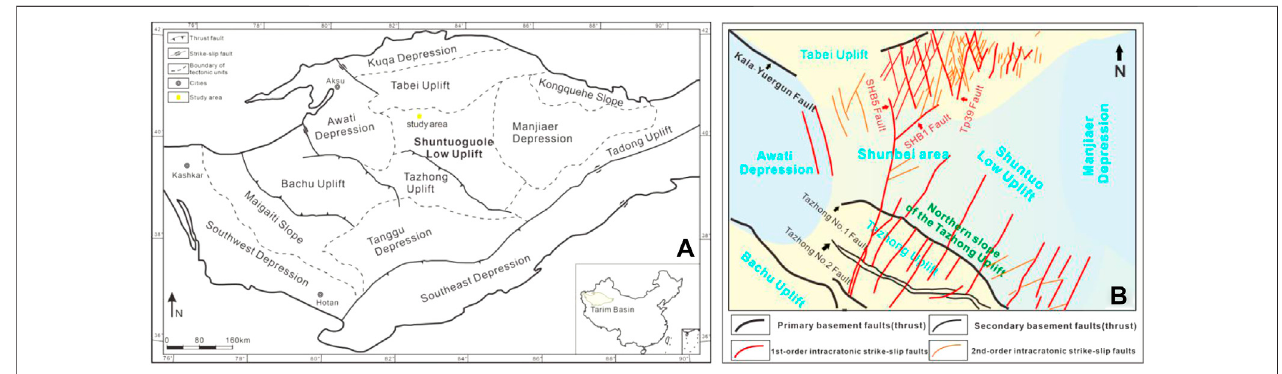
FIGURE1| TectoniclocationandregionaltectoniccharacteristicsoftheNo. (A) FaultZoneintheShunbeiareaofTarimBasin. (B) Distribution offaultsinthestudy area.